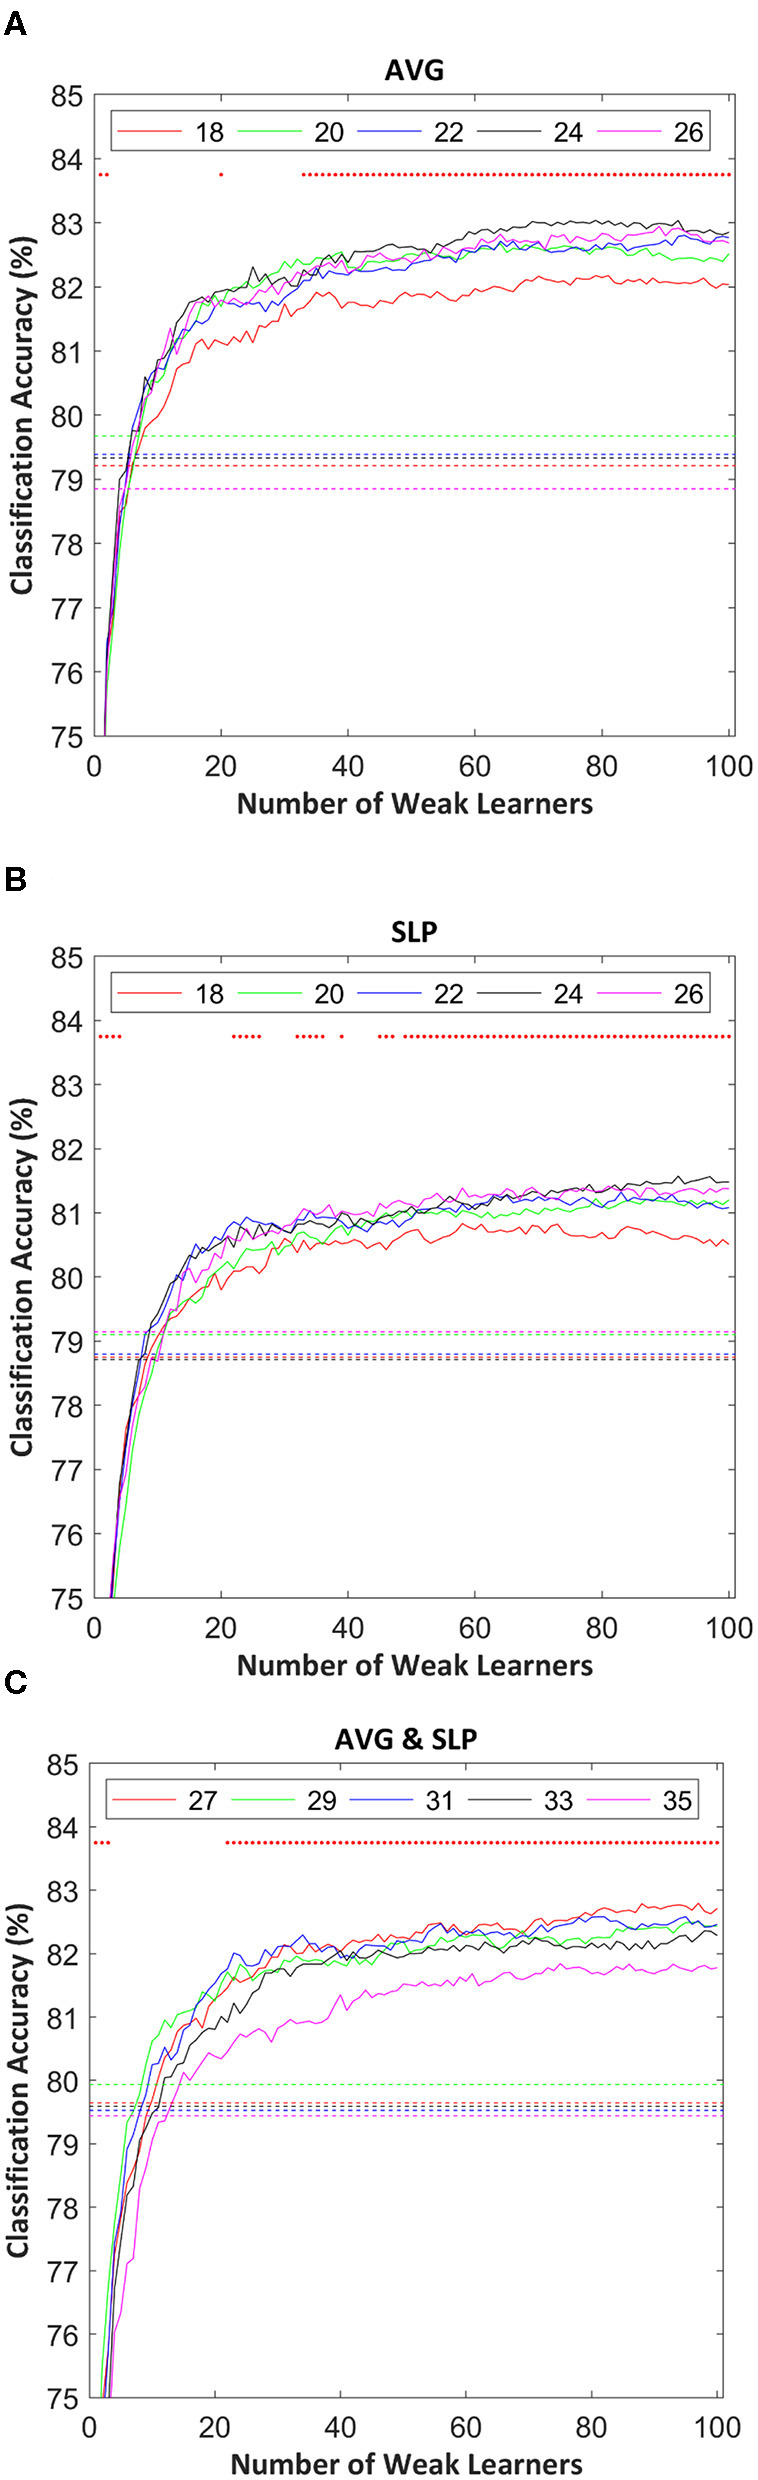
Random subspace ensemble classification accuracies estimated using: (A) AVG, (B) SLP, and (C) AVG and SLP features as a function of the number of weak learners. Dotted lines indicate SVM (strong learner) classification accuracy, estimated using the same 10-fold cross-validation partition used to validate the classification performance of the random subspace ensemble classifier. The random subset size for each weak learner is shown in the legend. Red dots in the upper part of each subfigure indicate the significance of differences in the classification accuracy between ensembles and strong leaners (t-test with false discovery rate corrected-p < 0.05).